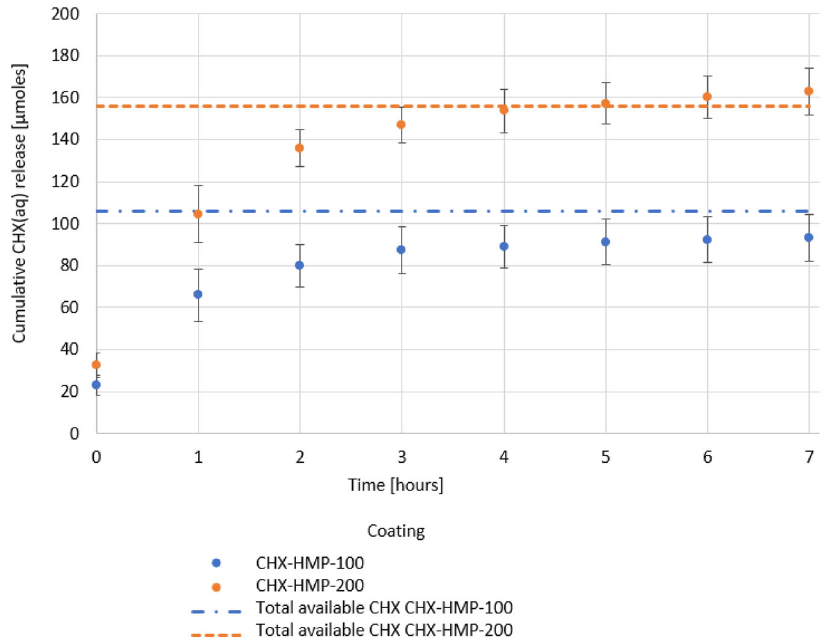
Fig. 2 Mean cumulative CHX (aq) release per metre squared of CHX-HMP coated SLA Ti. Elution into STF at room temperature. Error bars show standard deviation. Dotted lines represent pooled mean total available CHX on each coating type as determined using elution into 2 M HCl (10 specimens per coating